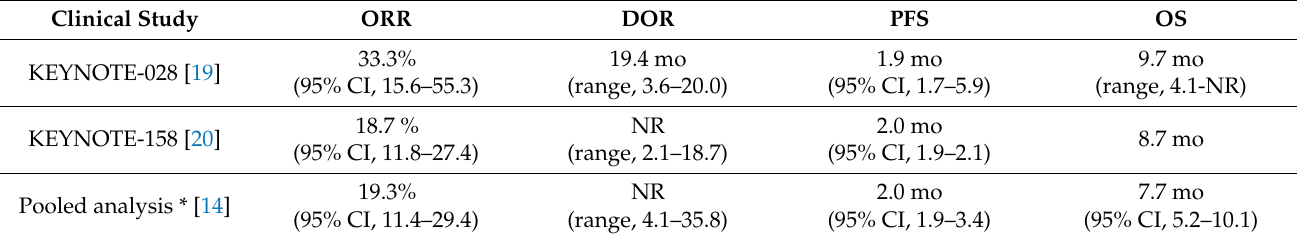
Table 2. Summary KEYNOTE-028 and KEYNOTE-158 trial